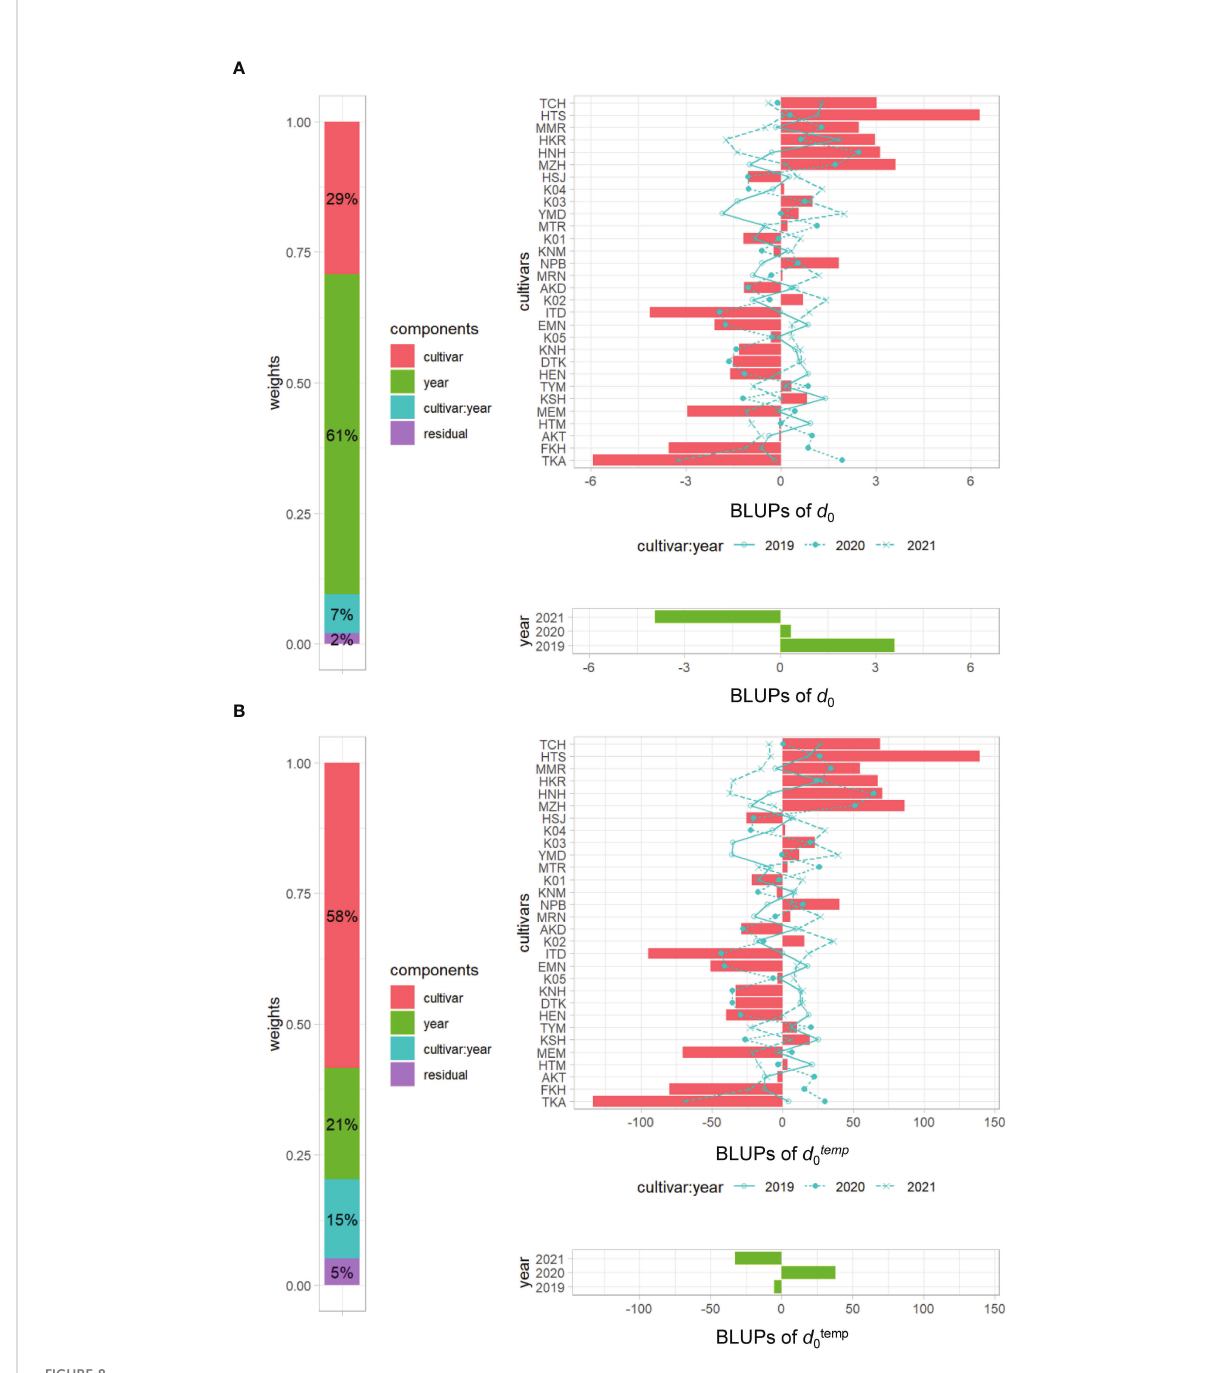
FIGURE 8 Visualization of the linear mixed effects model for (A) d 0 and (B) d 0 temp . Left, proportions of 4 variance components; right top, BLUPs of cultivar and cultivar × year interactions of 30 cultivars; right bottom, BLUPs of 3 years. Cultivars are sorted by d 1 . The numbers in cultivar components indicate percentage